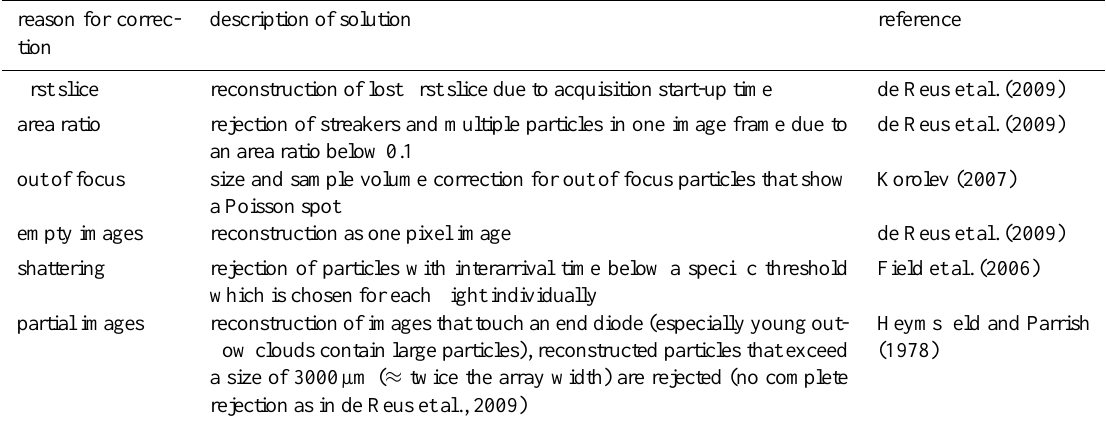
Table 1. Applied correction mechanisms for the CIP particle image analysis with the respective references. reason for